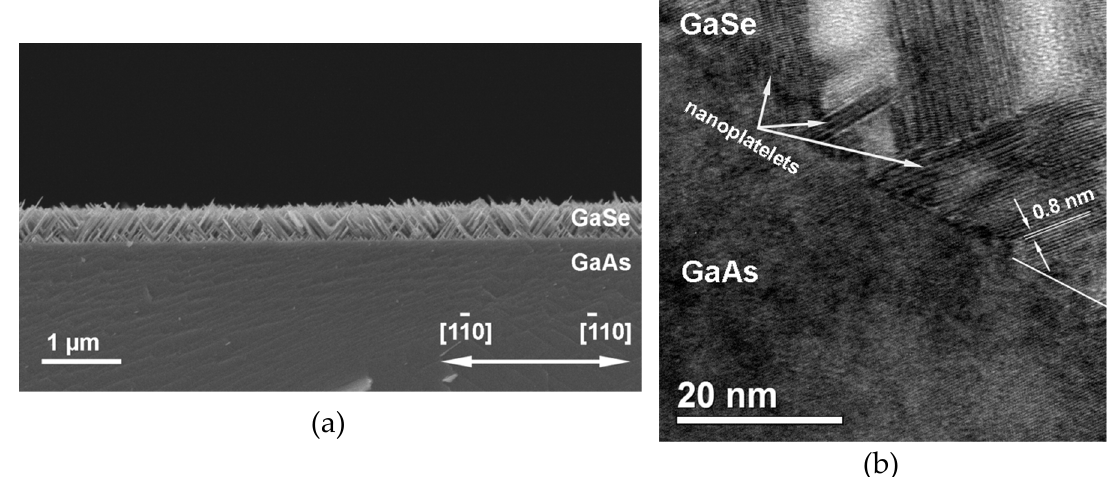
Figure 4. Cross-section SEM ( a ) and HRTEM ( b ) images of the GaSe layer grown on a GaAs(001) substrate at T S ~ 500 °C (Se/Ga (BEP) ~ 25) (sample # GS7 ).